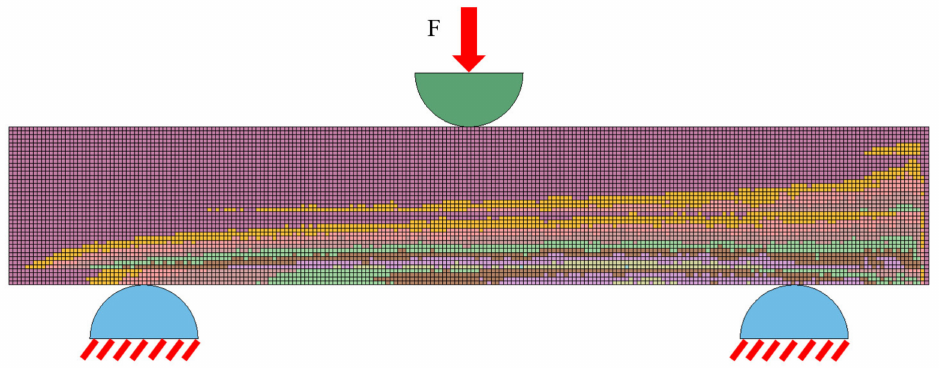
Figure 11. Scheme loading of the FE model of the bone sample characterized by a different system of densities in the three-point bending